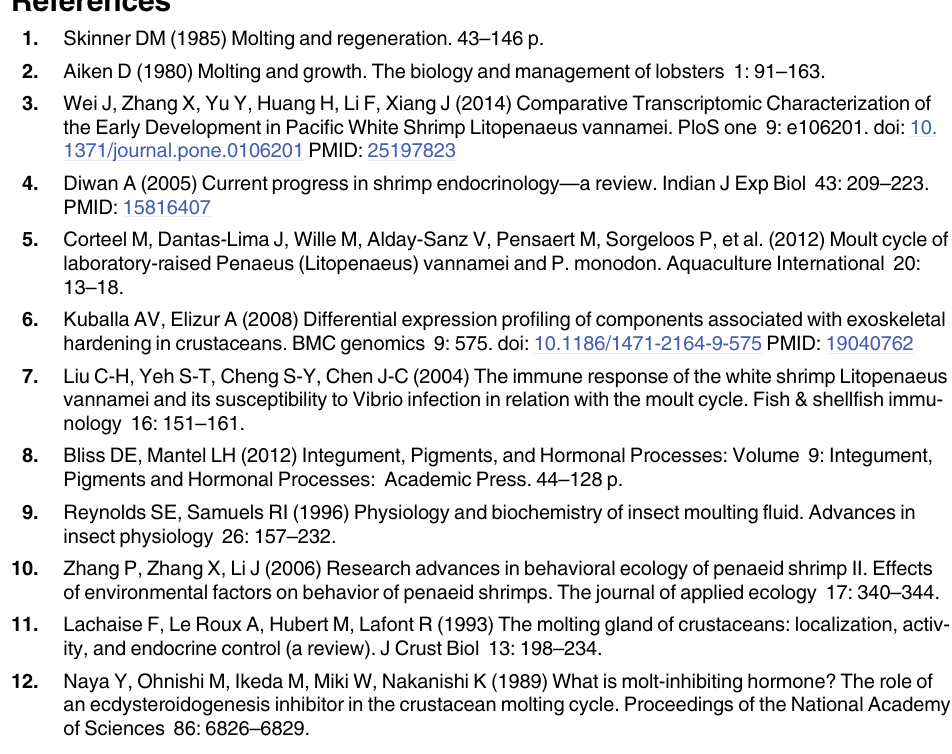
S3 Table. Expression profiles of all 5,117 DEGs from the L . vannamei molting cycle. Each row is a DEG identified from the molting transcriptome. Expression levels in all eight stages are provided for each unigene. S4 Table. Details of 259 putative pathways identified for the eight stages of molting. The name of the pathway, its hierarchy, and the number of members plus their gene IDs are pro- vided. S5 Table. Thirty-six immunity families, including 236 immune genes, categorized between molting stages. Gene ID, number of members and expression for the eight molting stages are given for each